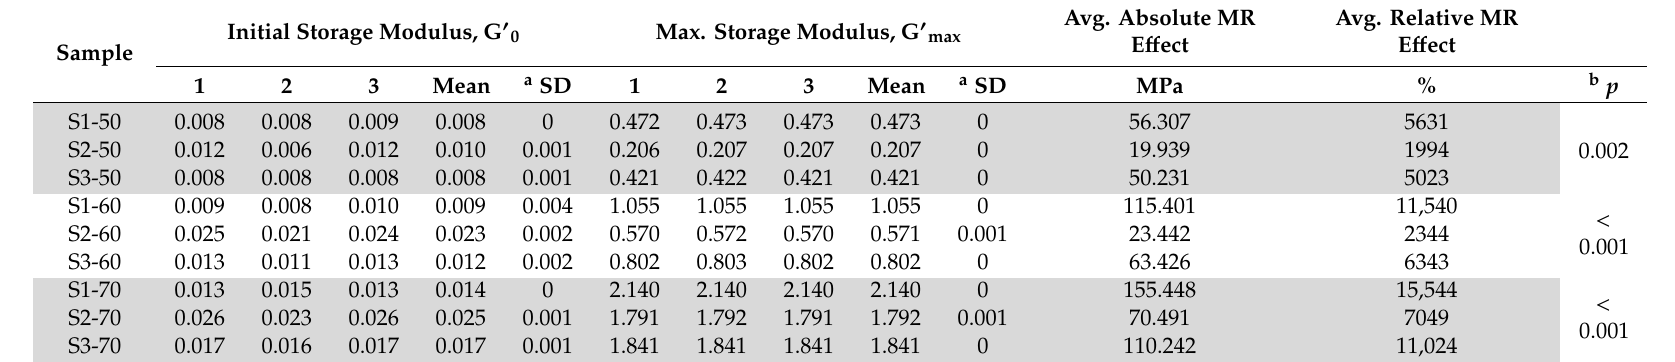
Table 1. The absolute and relative magnetorheological (MR) e ff ect hydrogel MRP with di ff erent solvents and CIPs content.